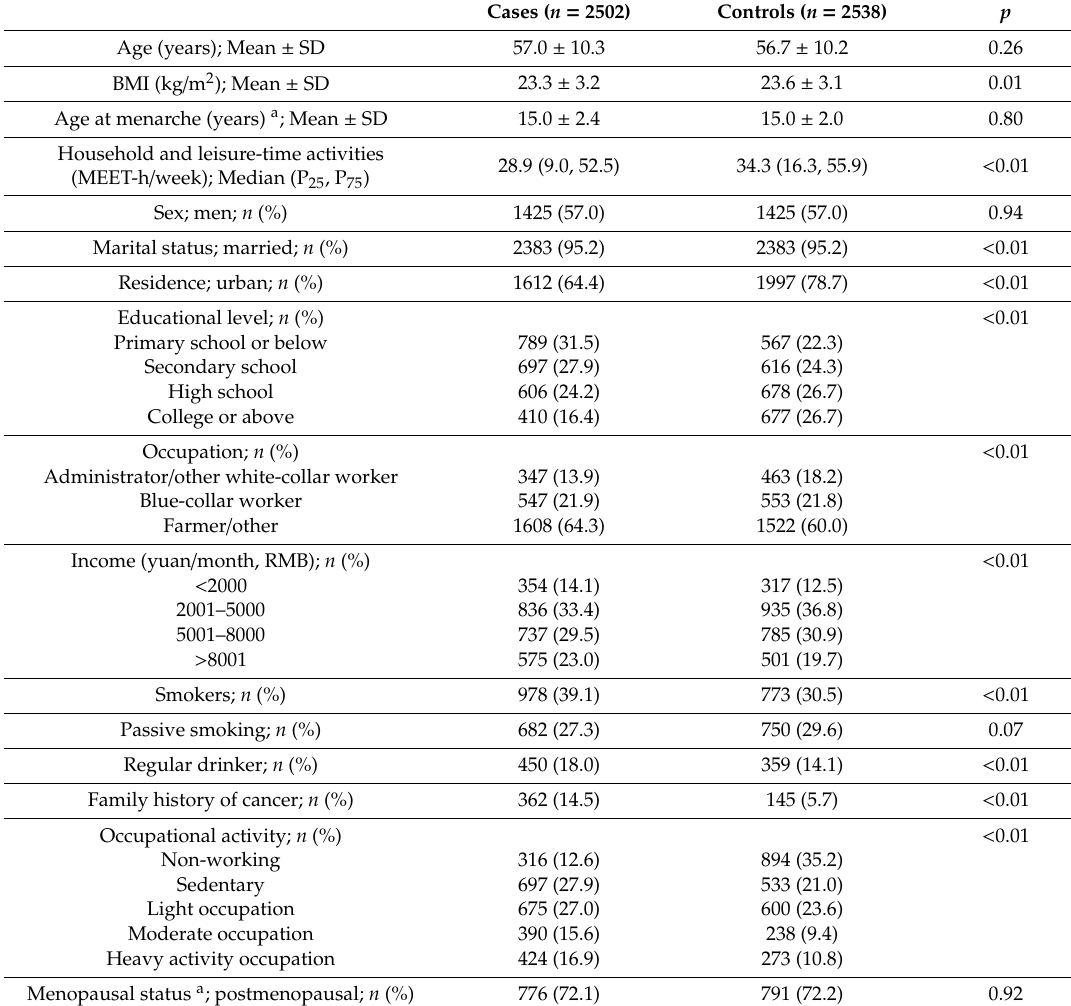
Table 1. Socio-demographic and clinical characteristics of colorectal cancer in the study population. Cases ( n =